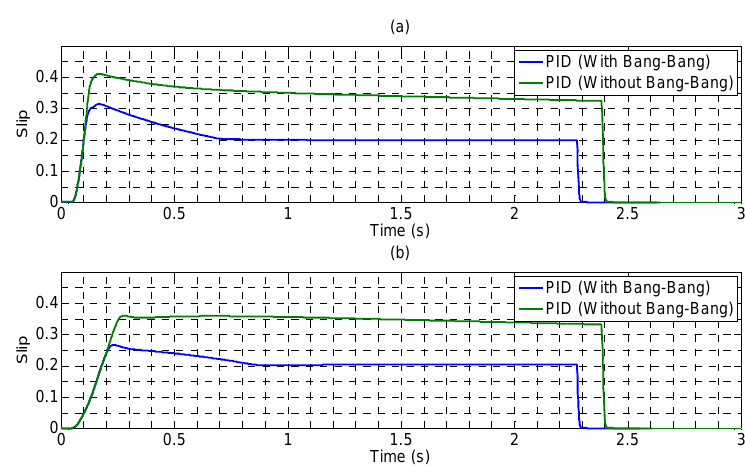
Figure 21. The difference results with and without the bang-bang controller in the PID controller: (a) front wheel; (b) rear wheel.